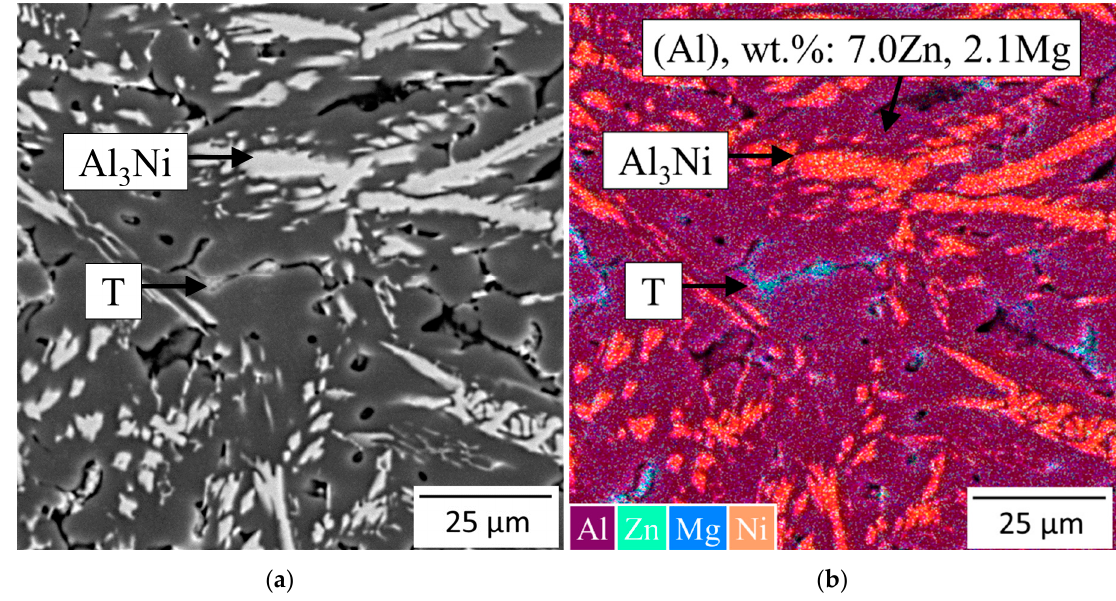
Figure 5. Microstructure of the 5 mm cast sample of the Al8Zn7Ni3Mg alloy: ( a ) SEM; ( b ) multilayer elemental map.